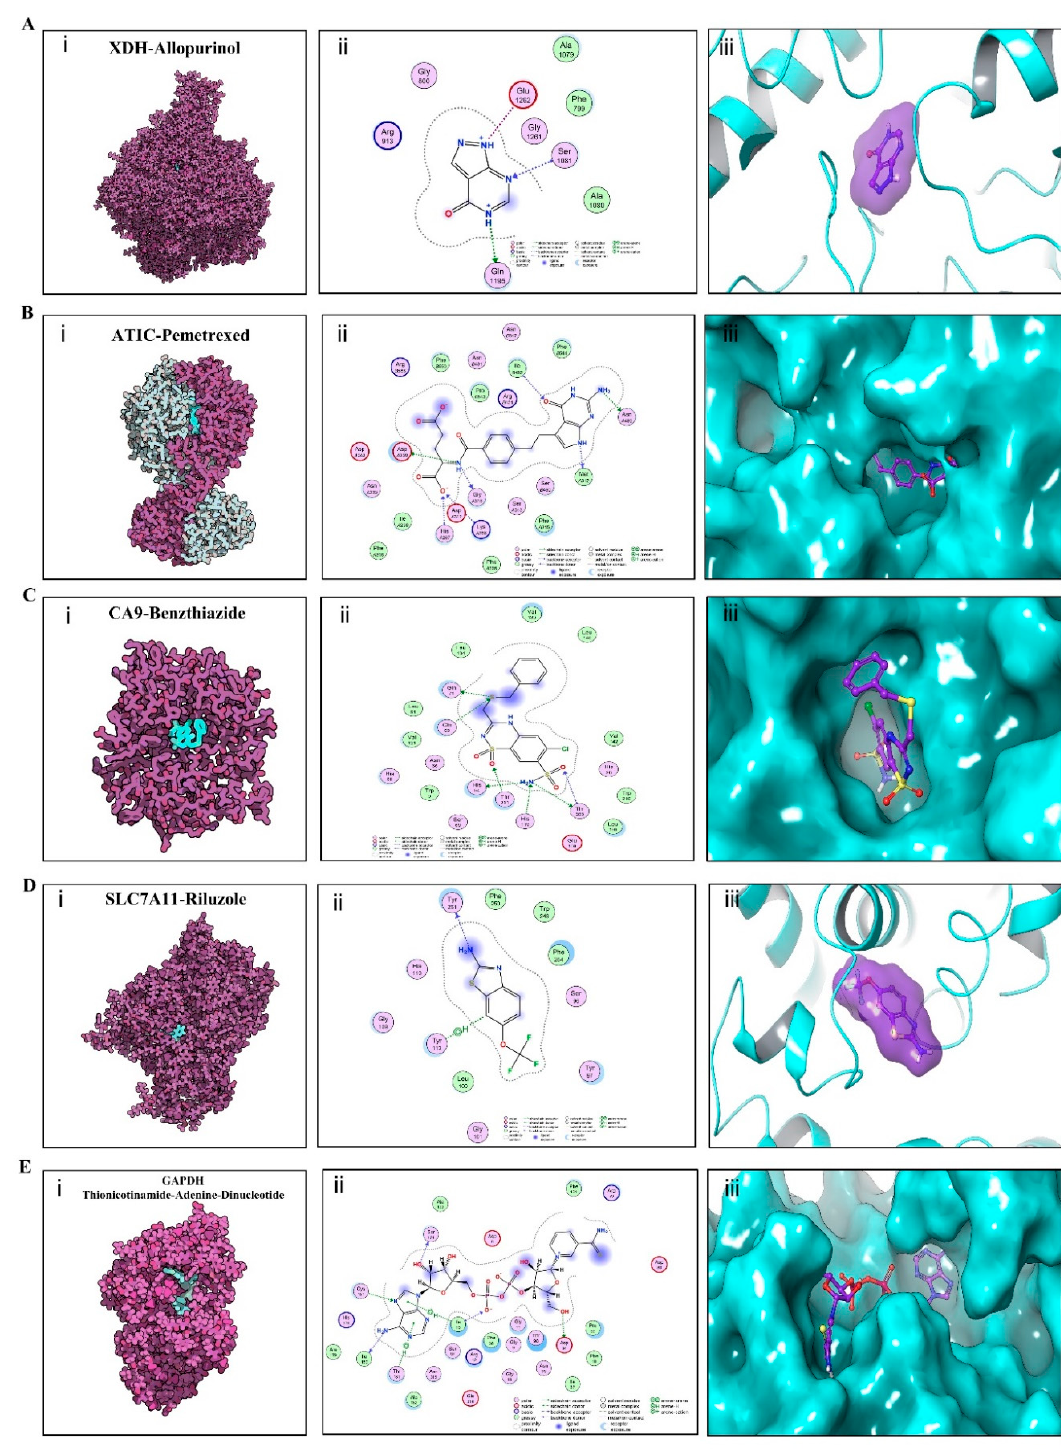
Figure 10. Binding mode of screened drugs to their targets by molecular docking. ( A ) Binding mode of XDH-Allopurinol complex. ( B ) Binding mode of ATIC-Pemetrexed complex. ( C ) Binding mode of CA9-Benzthiazide complex. ( D ) Binding mode of SLC7A11-Riluzole complex. ( E ) Binding mode of GAPDH-(Thionicotinamide-Adenine-Dinucleotide) complex. ( i ), Cartoon representation, overlay of the crystal structures of small molecule compounds and their targets were illustrated by Molecule of the Month feature. ( ii ), 2D interactions of compounds and their targets. ( iii ) 3D structures of binding interface were showed by PyMOL software.